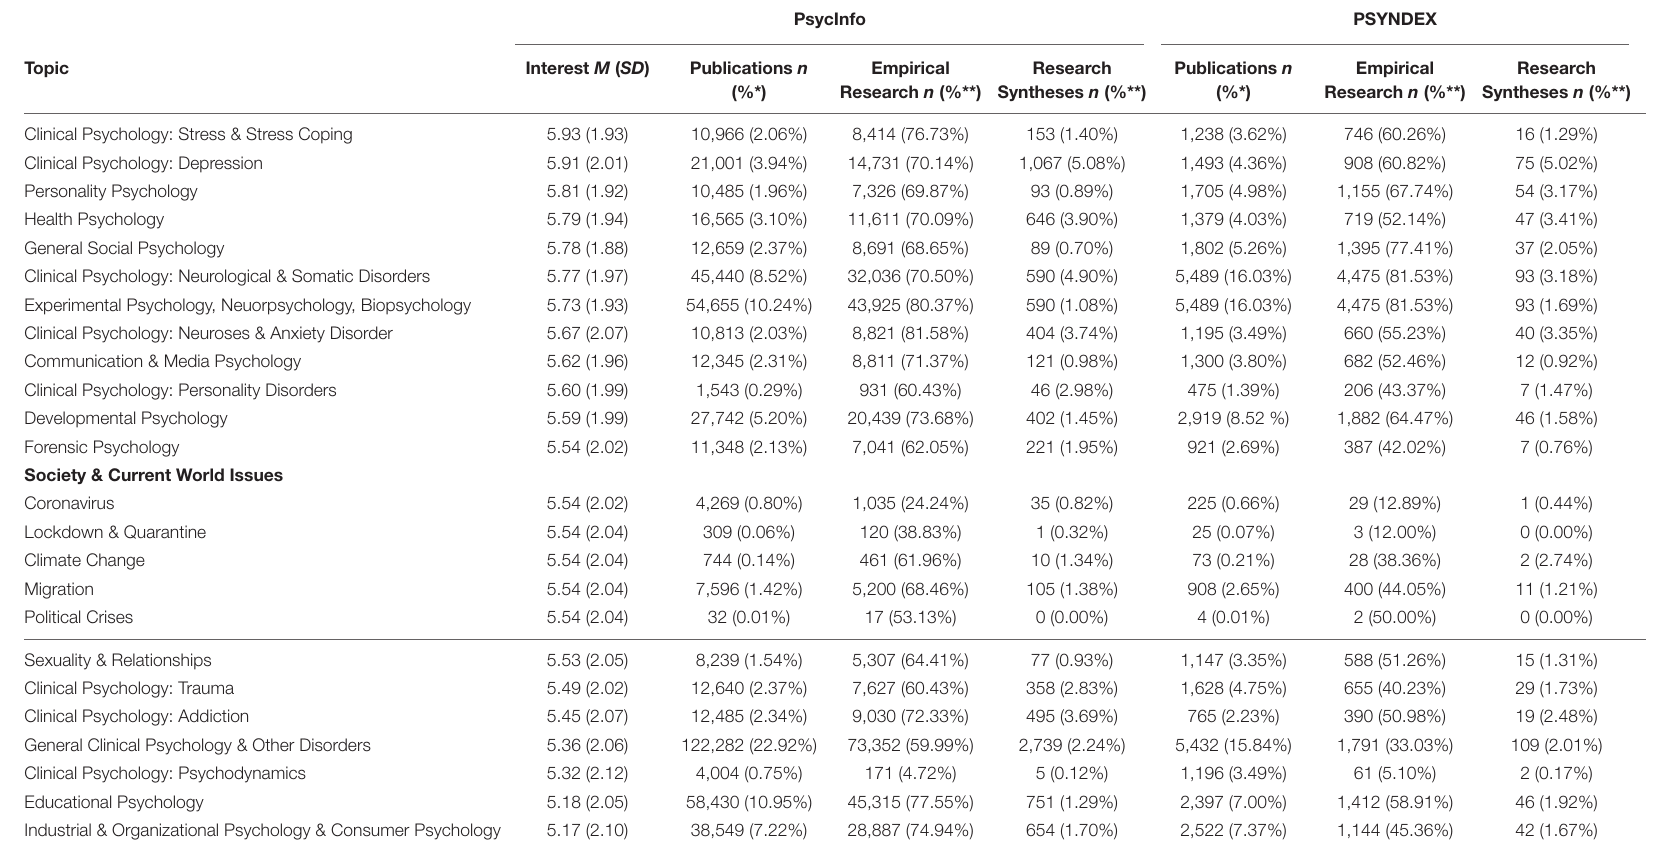
TABLE 1 | Laypersons’ topics of interest and related records in psychological